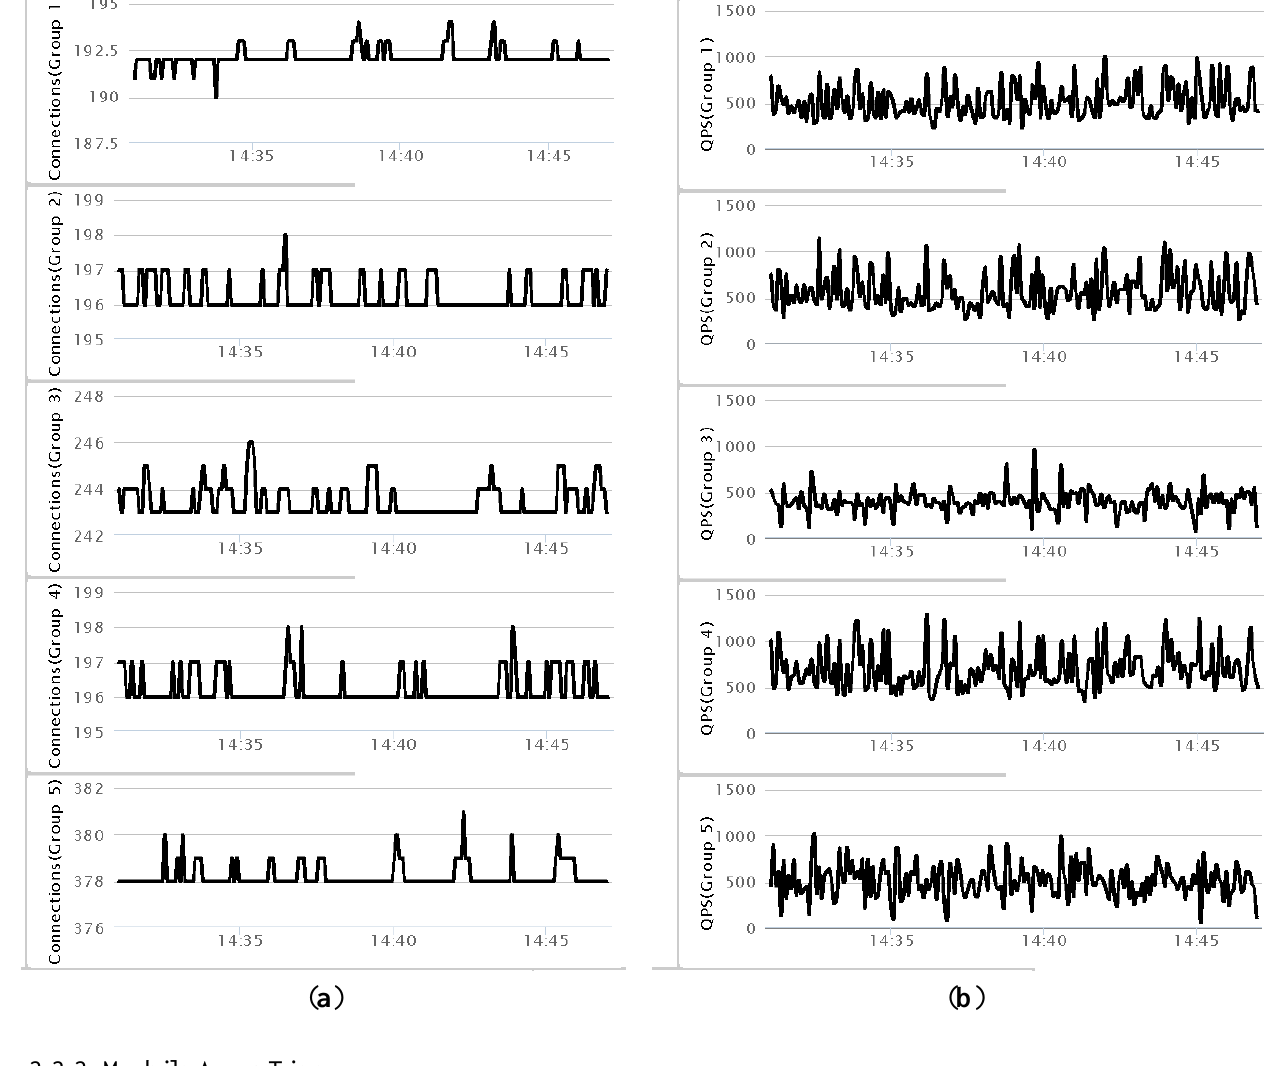
Figure 19. The performance visualization of the distributed Redis framework: ( a ) Number of connections; ( b ) queries per second,